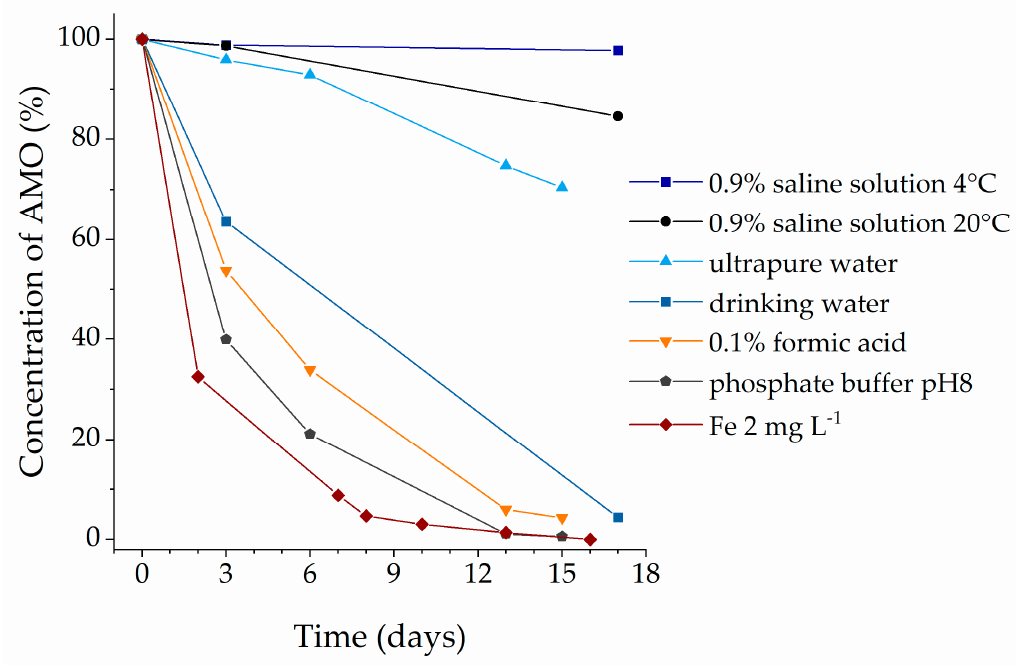
270 nm. Samples were stored under the influence of light for 70 days at room temperature.